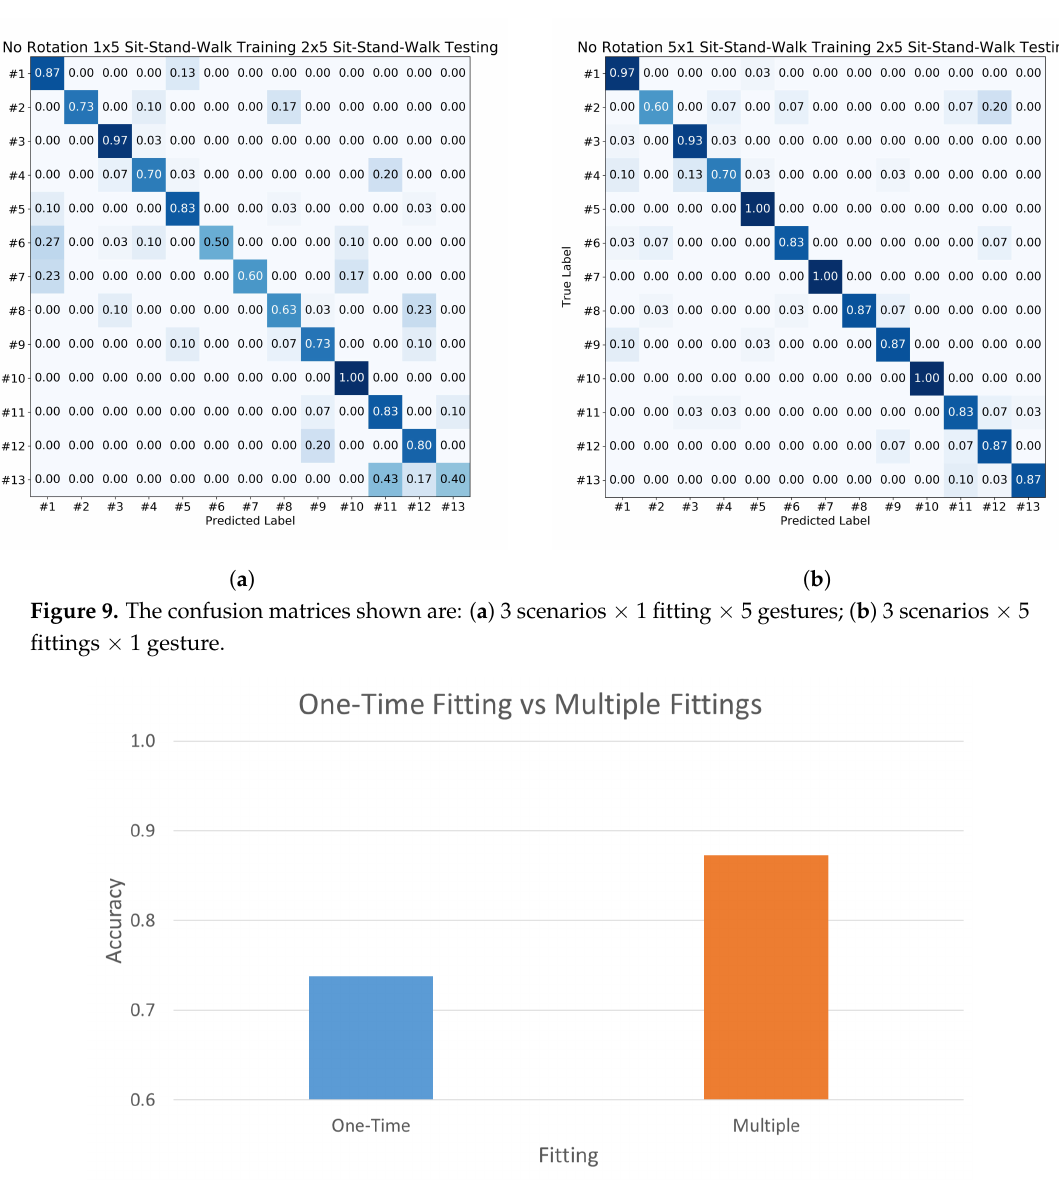
Figure 10. One-time fitting of Myo Armband versus multiple fittings of Myo Armband.